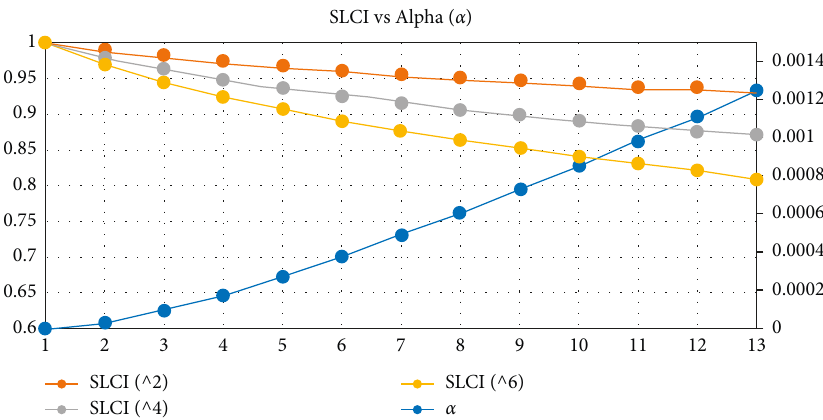
Figure 5: The graphical illustration of changes in SLCI according to different alpha